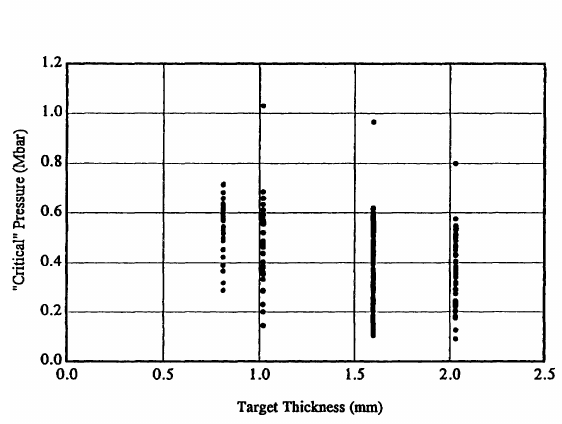
FIGURE 6 Basic model: Critical pressure versus target thickness.